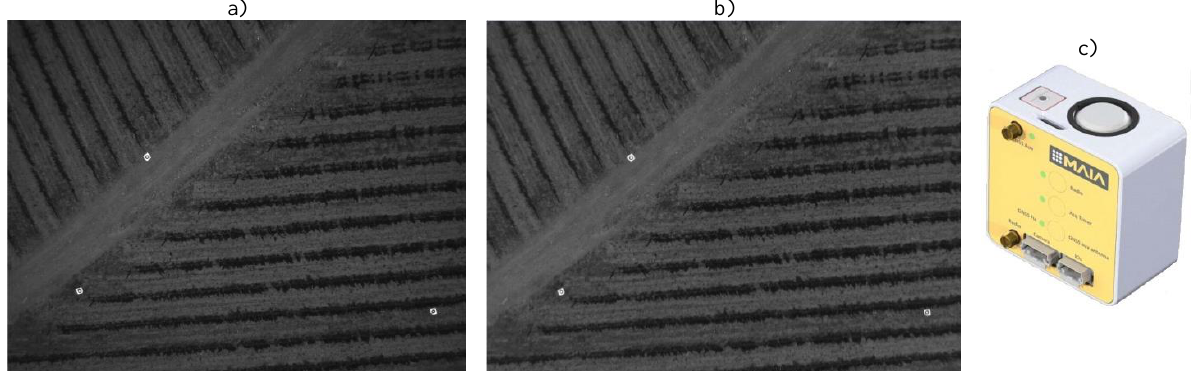
Figure 5: A monochromatic image in band 1 (Violet) of MAIA/S2 before (a) and after (b) the vignetting correction (b). The designed MAIA Irradiance Light Sensor - ILS